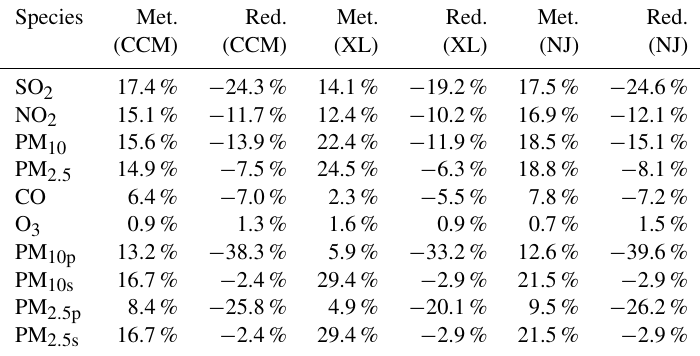
Table 6. Comparison between the simulated effect of meteorology and emission reduction at CCM and XL stations. Met. is the change percentage of species in Experiment 2 based on Experiment 3, representing the effect of meteorology. Red. is the change percentage of species in Experiment 1 based on Experiment 2, representing the effect of Nanjing local emission reduction. Species Met. Red. Met. Red. Met. Red. (CCM) (CCM) SO